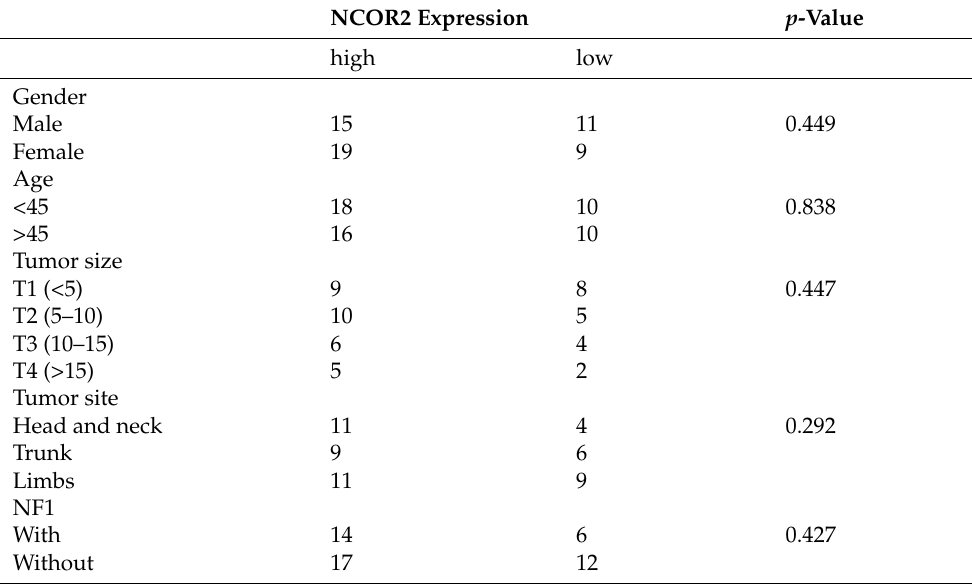
Table 1. Clinical parameter with NCOR2